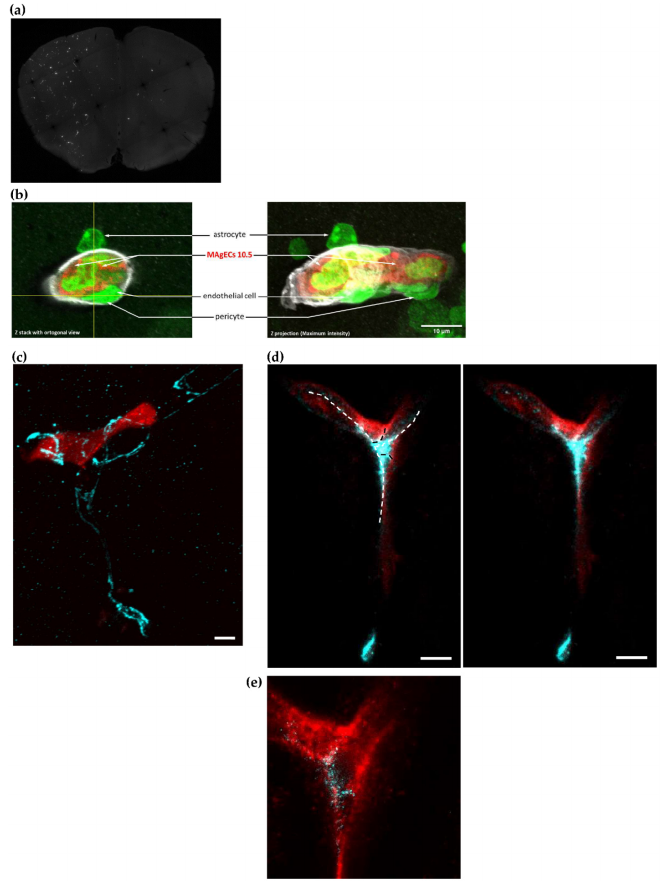
tions between the injected MAgEC 10.5 RT as well with unlabeled resident endothelial cells (Figure 6d,e). We concluded that the injected MAgEC 10.5 RT were integrating into the capillary bed.